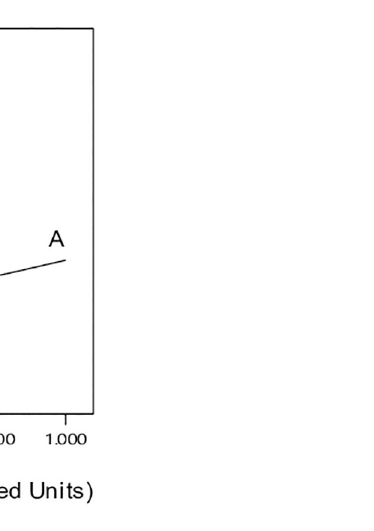
Fig 15. Perturbation chart for crystal size